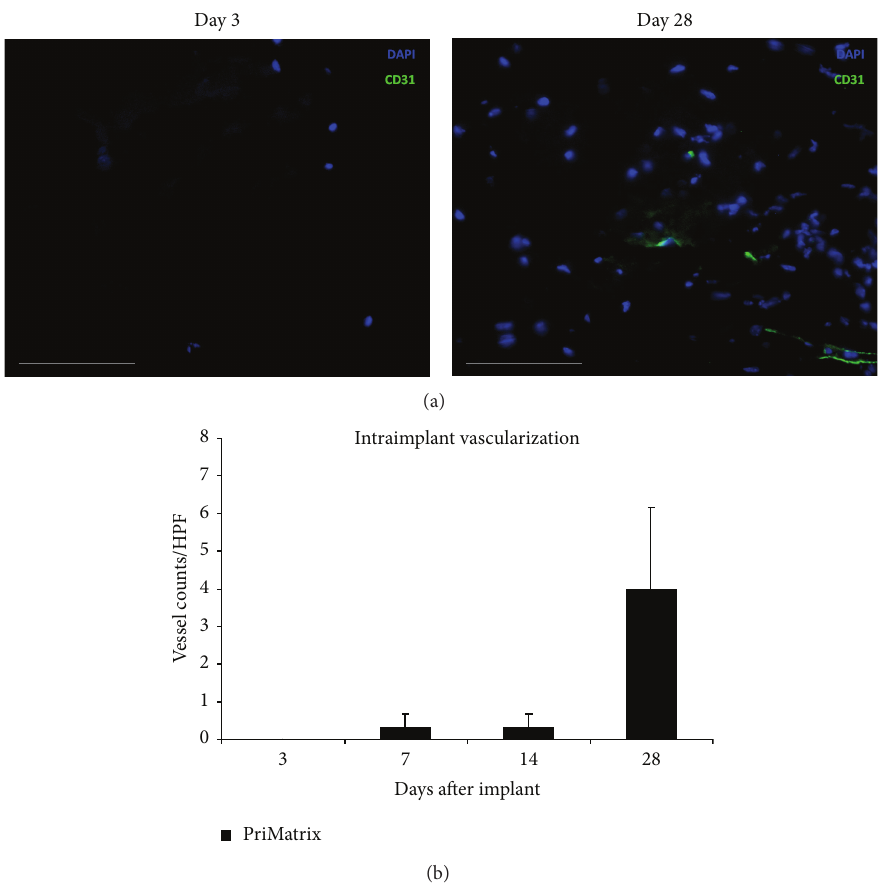
Figure 4: Characterization of intraimplant vascularization. (a) Representative high power images of intraimplant immunofluorescence staining for the endothelial cell-specific marker CD31 at days 3 and 28, showing foci of intraimplant neovascularization. (b) Quantification of intraimplant vessel counts per high power field. Scale bar is 100 𝜇 m. DAPI: nuclear